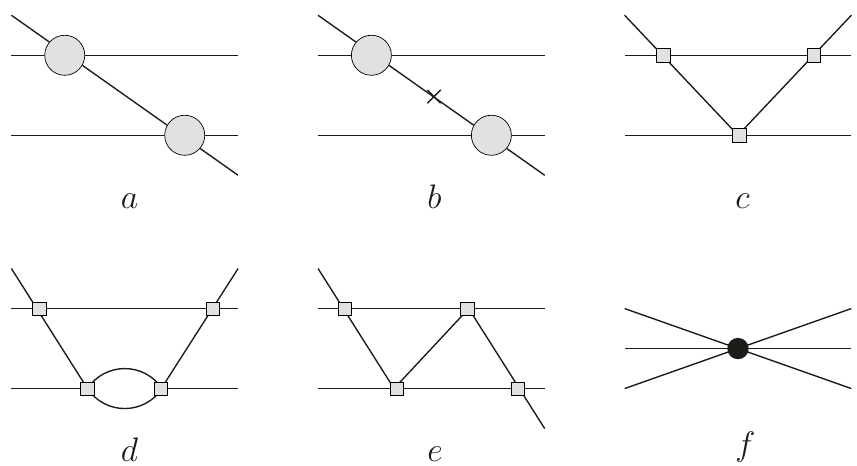
Figure 3. Diagrams that contribute to the non-vanishing three-particle scattering amplitude at threshold. The large shaded blobs in the diagram a depict the two-body scattering amplitude at O ( p 2 ) , the shaded squares correspond to the vertices with the non-derivative coupling g 1 , the cross in the diagram b depicts the relativistic insertion p 4 / (8 m ) , and the large filled circle in the diagram f corresponds to the three-particle coupling η 3